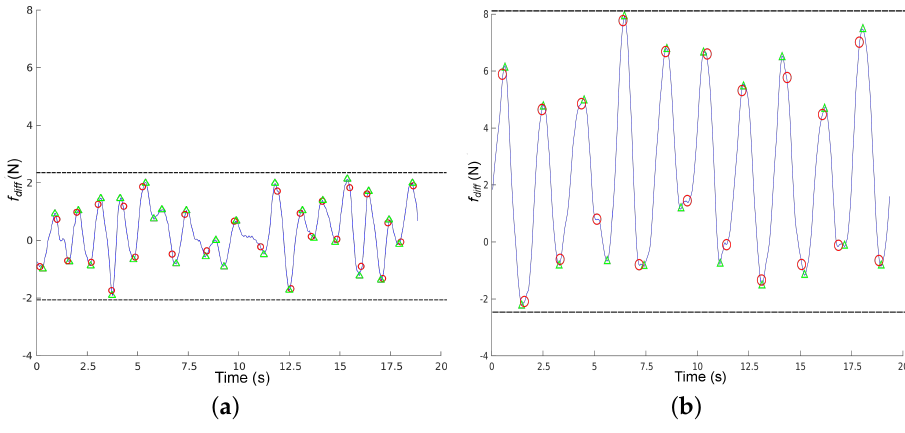
Figure 9. Volunteer heel strikes plotted over f dif f . The detection of heel strikes are plotted as: (cid:52) for the i-Walker and (cid:13) for Optotrak system. ( a ) Healthy volunteer and; ( b ) challenged volunteer with a stroke. Left side support more